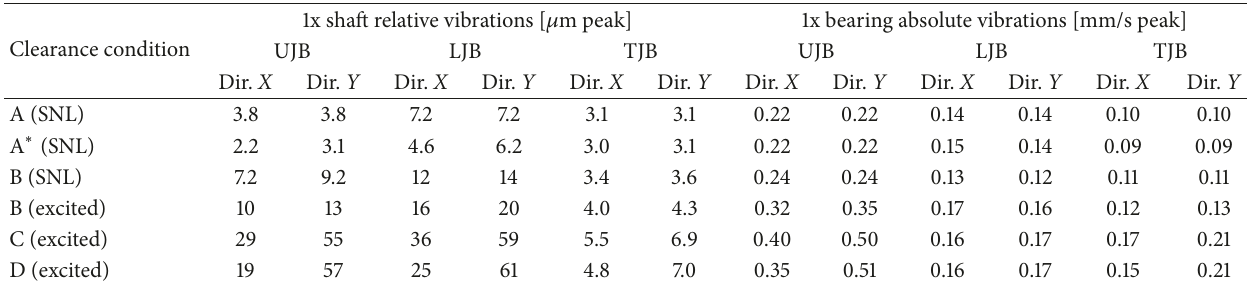
Table 6: Simulated shaft and bearing vibrations at upper (UJB), lower (LJB), and turbine journal bearings (TJB), with the LHG at speed-no-